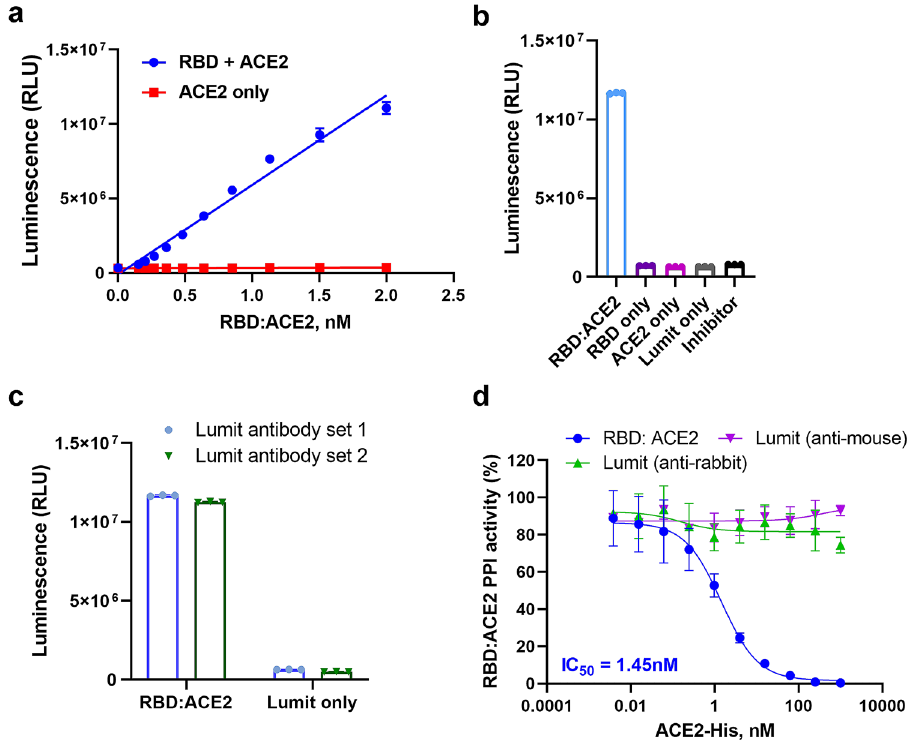
Figure 2. Validation of Lumit SARS-CoV-2 Spike RBD:ACE2 Immunoassay. ( a ) Assay linearity of Lumit SARS- CoV-2 Spike RBD:ACE2 Immunoassay. SARS-CoV-2 Spike RBD:ACE2 titration was performed in 1× Buffer. ( b ) Spike RBD:ACE2-mediated antibody proximity leads to NanoLuc complementation and bioluminescent signal. The absence of either assay component results in loss of signal. Bioluminescence is dependent on the RBD:ACE2 interaction as evidenced by inhibition with anti-Spike RBD antibody. ( c ) SARS-CoV-2 Spike RBD:ACE2 detection is not affected by the orientation of NanoLuc reporter fragment in secondary antibodies. Set 1: Lumit Anti-Mouse Ab-LgBiT/Lumit Anti-Rabbit Ab-SmBiT. Set 2: Lumit Anti-Mouse Ab-SmBiT/Lumit Anti-Rabbit Ab-LgBiT. ( d ) RBD:ACE2 interaction is inhibited by soluble ACE2-His. As control, ACE2-His dilutions were incubated with a luminescence-generating reaction that contained either 1.5 nM RBD-rabbit Fc and Lumit Anti-Rabbit (SmBit/LgBit) antibodies, or 1.5 nM ACE2-mouse Fc and Lumit Anti-Mouse (SmBit/ LgBit) antibodies in 1× Lumit immunoassay reaction buffer, and assay was performed as described above. Results are presented as means ± S.E.M. (n = 3 technical replicates, the data are representative of two or more